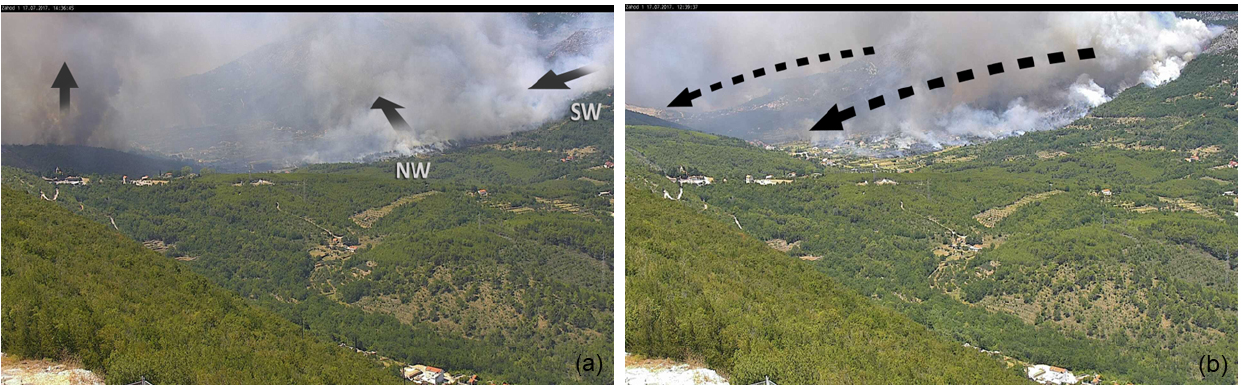
Figure 3. Photographs from the Zahod location of (a) the mosaic fire front and wildfire spread down into the valley in SW direction between the SPLIT 1 and SPLIT 2 period (at 10:39UTC on 17 July) and (b) fire smoke rising in different directions in the early afternoon hours during the SPLIT 2 period (at 12:30UTC on 17